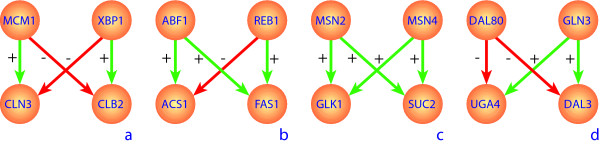
Examplars of bi-fan behaviour observed in the TRANSFAC database for S. cerevisiae. Inhibitory interactions are shown in red, while promoting interactions are shown in green.